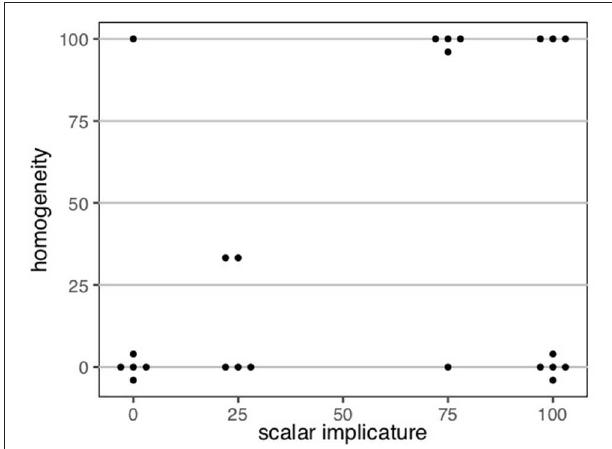
TABLE 2 | Predicted responses to each condition ([determiner]-[context]-[polarity]) for each of the six possible groups, defined by the reading for the